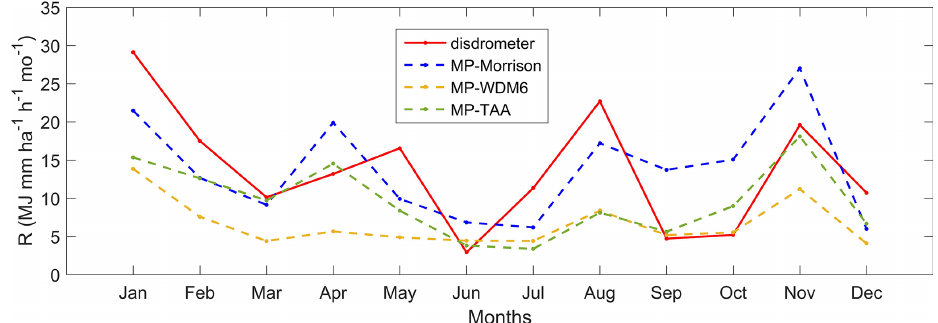
Figure 8. Comparison of disdrometer- and WRF-derived average monthly rainfall erosivity estimations at Chilbolton station (2014–2017).